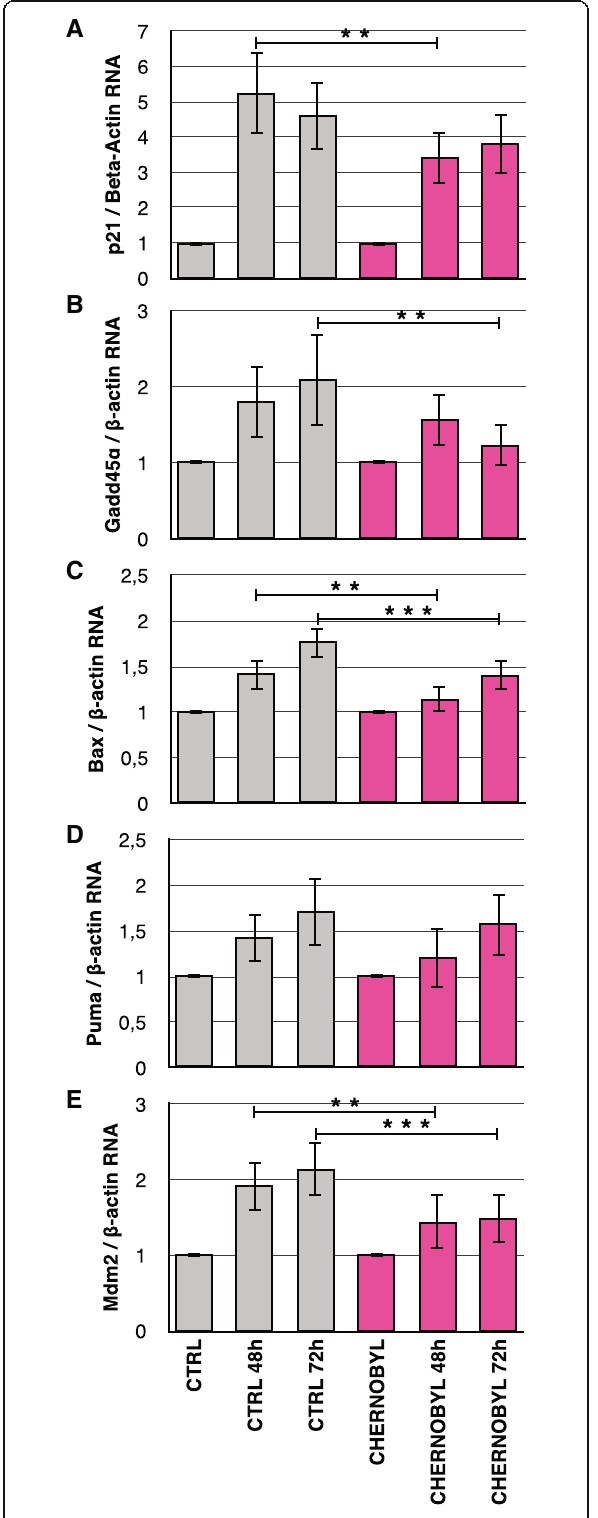
Fig. 5 P53-target genes are induced more strongly in control cells than in Chernobyl bank vole fibroblasts. RNA was collected from untreated and etoposide-treated (20 μ M) cells 48 and 72 h after the drug treatment. CDNA was prepared and quantitative-PCR was run with gene specific primers, and transcript levels were standardized to beta-actin transcript. Results are shown as a fold increase from untreated samples for a .) p21, b .) Gadd45 α , c .) Bax, d .) Puma, and e .) Mdm2. The results are from three separate experiments using the eight Chernobyl ( N = 24) and eight control cell lines ( N = 24), variation is shown by standard deviation, and statistical analysis was done with Student ’ s t-test (** = p ≤ 0.01, *** = p ≤